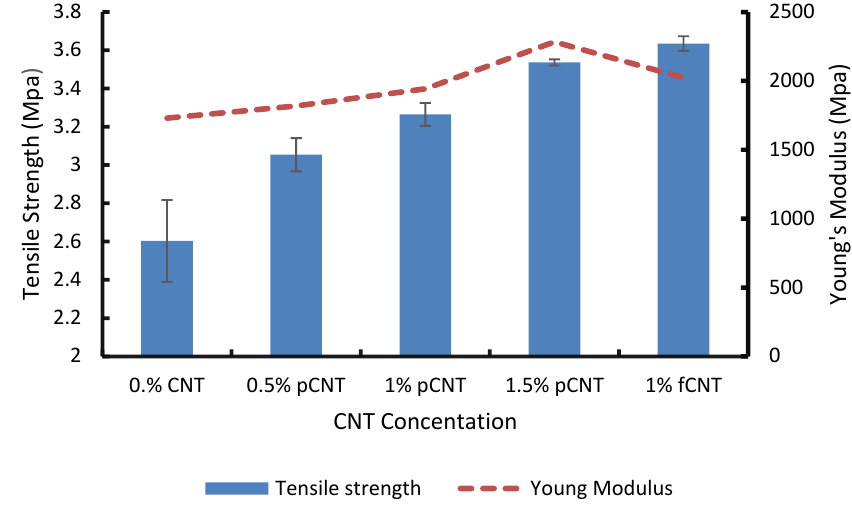
Figure 3. Young’s modulus for CNT / PSF / PES blended membranes.